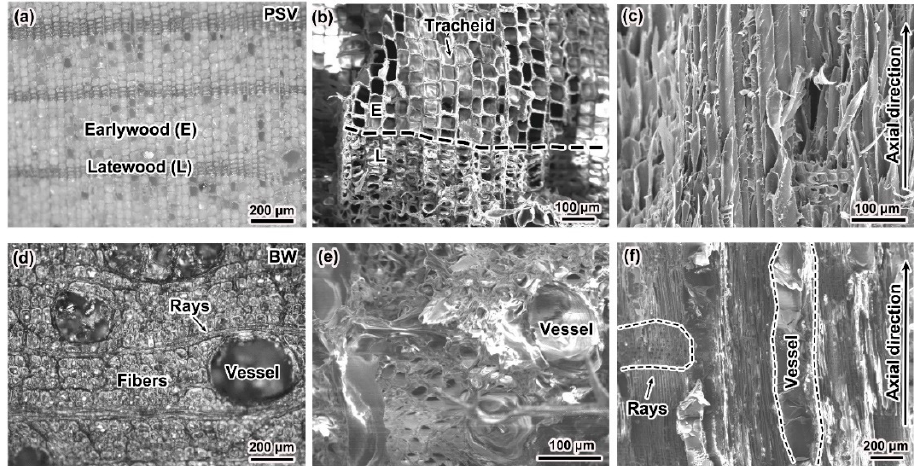
Figure 2. Microstructures on the transversal plane ( a , b ) and longitudinal plane ( c ) of PSV, and transversal plane ( d , e ) and longitudinal plane ( f ) of BW.